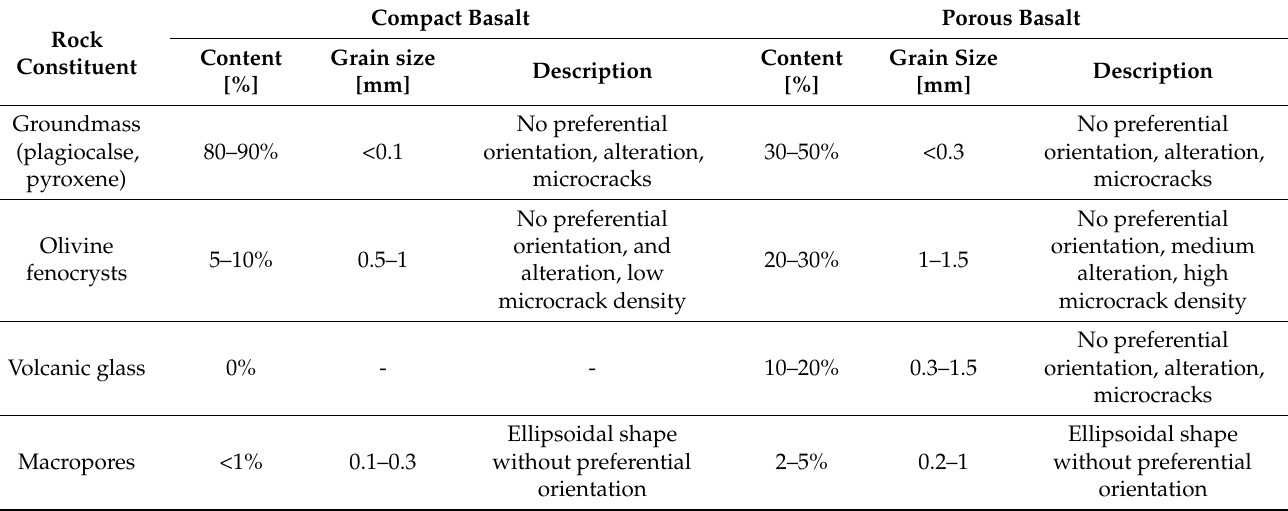
Table 1. Basic petrographic characteristics of the tested rock estimated from the microscopic photographs.